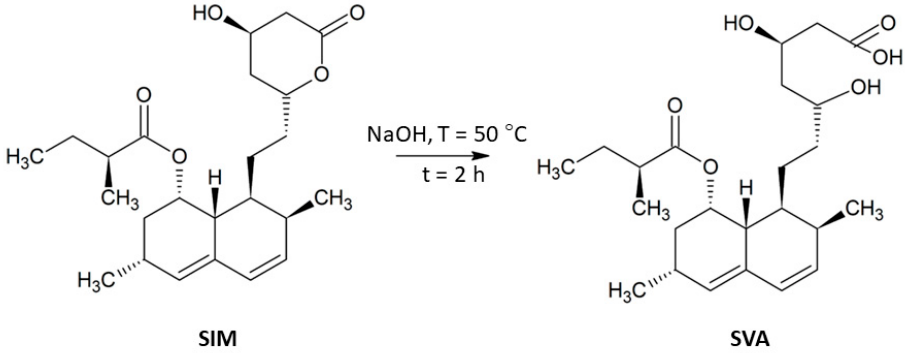
Figure 1. The route of the simvastatin hydrolysis reaction.